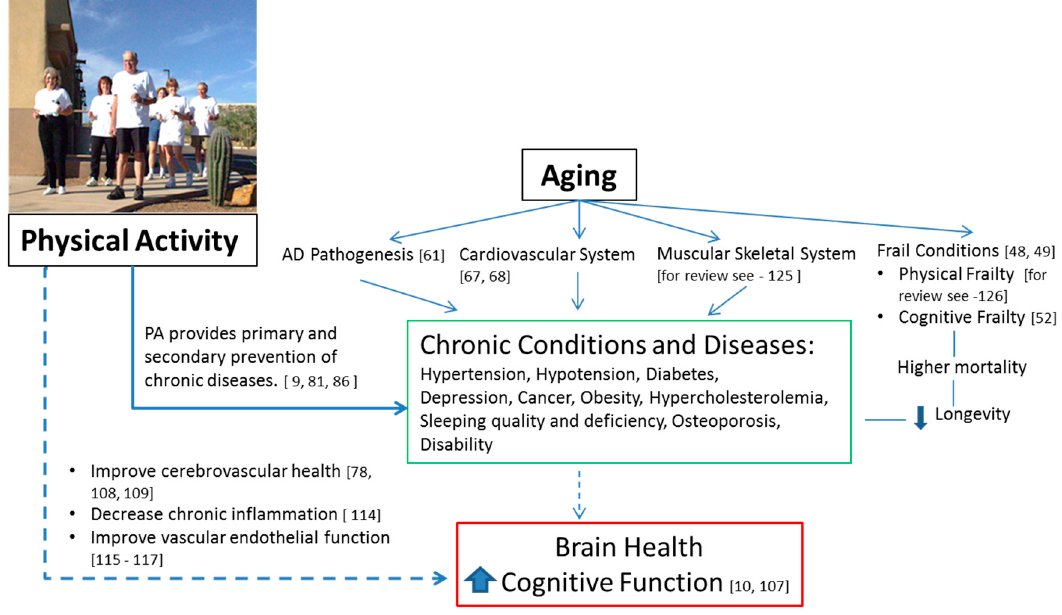
Figure 1. The evidence of PA’s role in reducing the risks of cognitive decline in older adults. The dotted arrows indicate that more research is warranted.